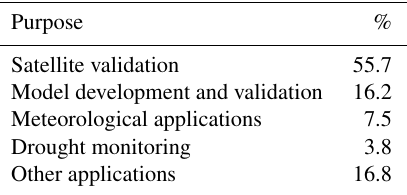
Table 5. Overview of purposes for which ISMN data are used in scientific studies (status in July 2021; n =